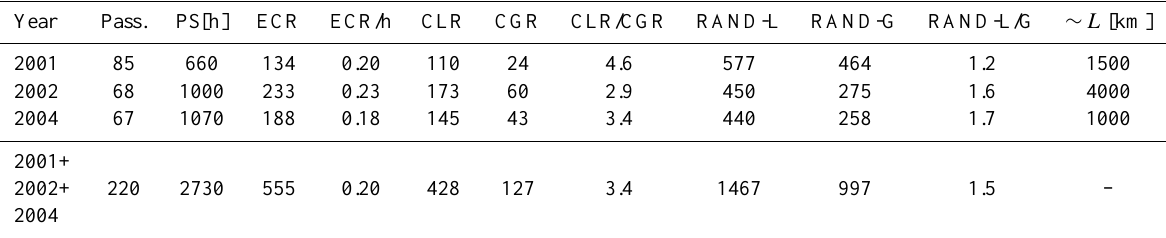
Table 1. Overview of the events included in our data base. Data are presented for each individual year (2001, 2002, and 2004) as well as for all three years together. The second and third column contain the number of Cluster plasma sheet crossings and the total number of hours investigated in the plasma sheet. In column four and five, the total number of ECRs and the occurrence frequency (number of ECRs per hour) are presented. The individual number of CLRs and CGRs, respectively, are presented in column six and seven, while column eight contains the ratio between the number of CLRs and the number of CGRs. Column nine to eleven contain similar information, but for the RAND data. In the final column, information on the characteristic scale size of the tetrahedron can be